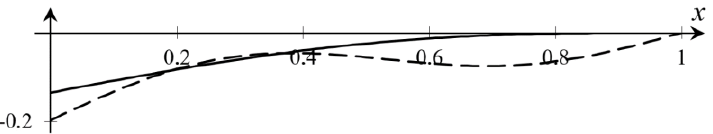
. ( x ,6 ) (solid line) and Q 2 ( x ,6 ) (dashed line). 1